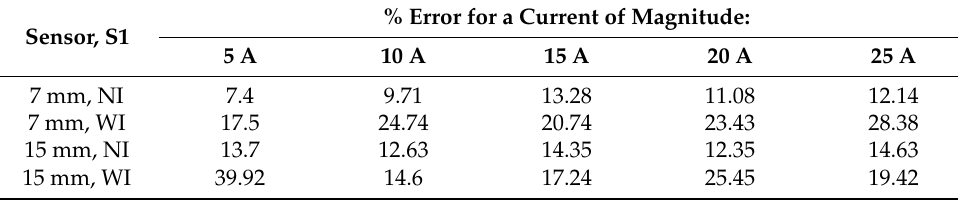
Table 1. Results of sensor S1 using Faraday’s law for various cases. Sensor,